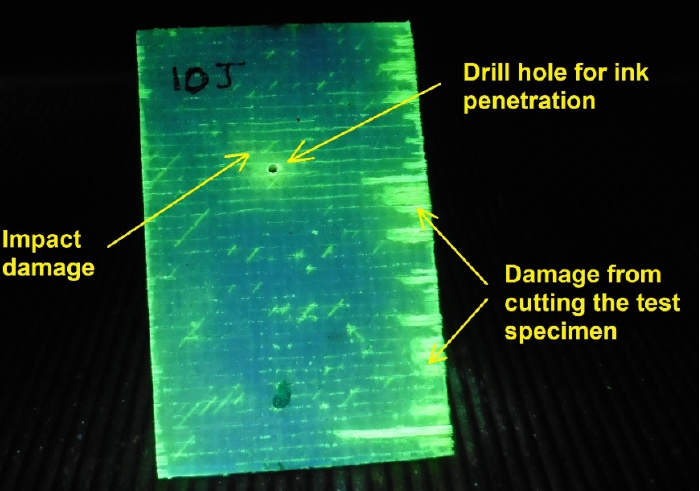
Figure 8. Specimen tested at 10 joules impact after being immersed in penetrant ink and exposed to ultraviolet light.